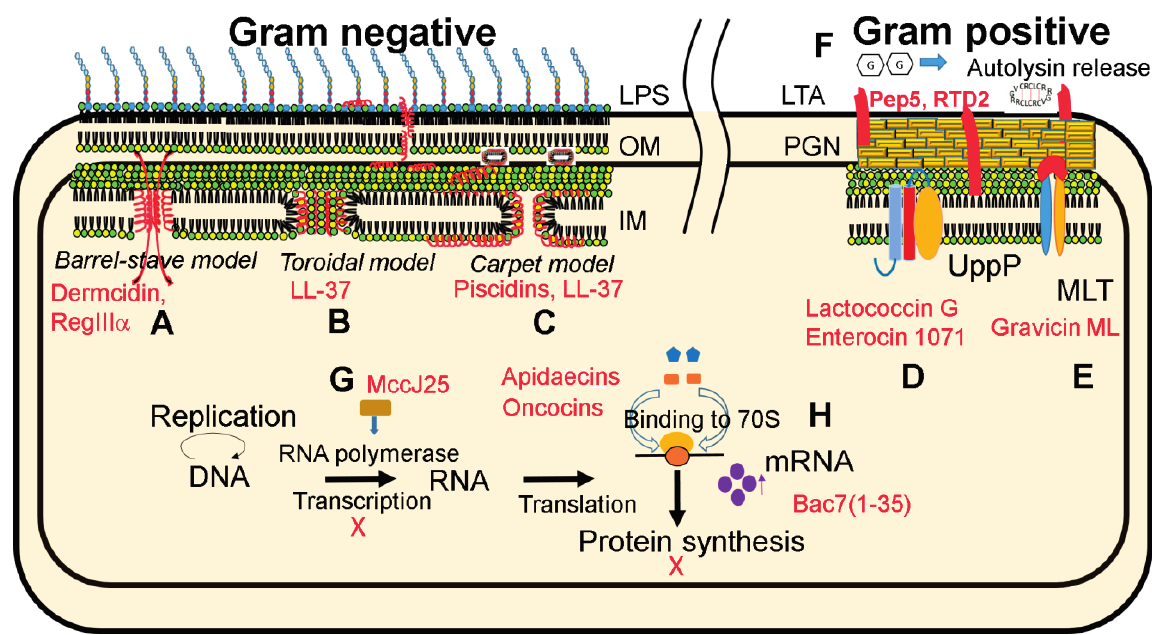
Figure 1. Mechanisms of action of antimicrobial peptides in 2014. Membrane